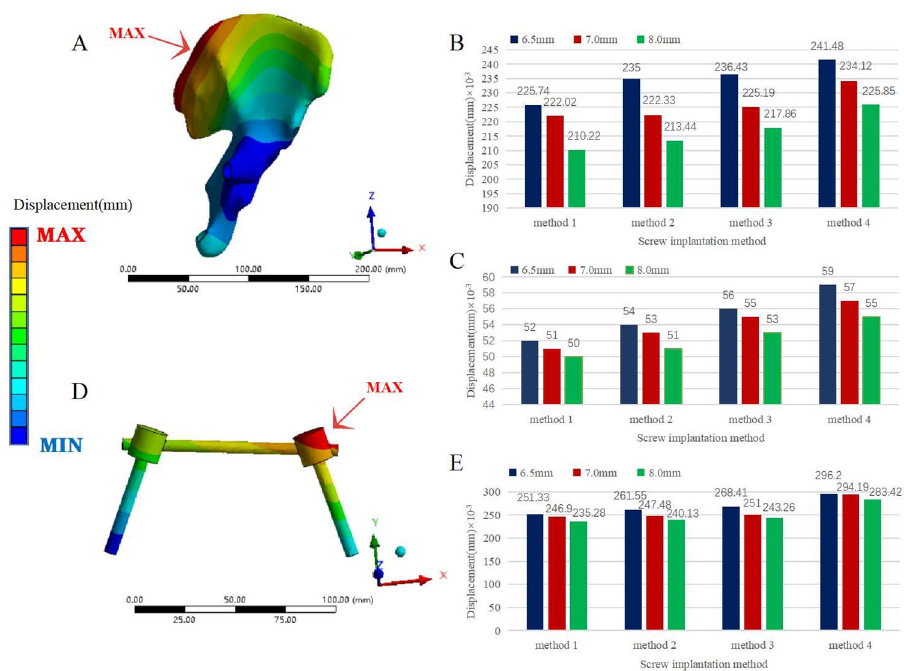
Fig 7. Displacement comparison of pedicle screw fixation models with different diameters and fixation methods. (A) Displacement distribution of the iliac bone of the pelvis model fixed with pedicle screws under a vertical load. (B) Comparison of the maximum displacement of the iliac bone of the pelvic model with pedicle screws of three diameters and four fixation methods under a vertical load. (C) Comparison of the maximum displacement of the pubic ramus fracture of the pelvic model with pedicle screws of three diameters and four fixation methods under a vertical load. (D) Displacement distribution of the pedicle screw rod in the posterior ring of the pelvic model fixed with pedicle screws under a vertical load. (E) Comparison of the maximum displacement of the pedicle screw rod in the posterior ring of the pelvic model with pedicle screws of three diameters and four fixation methods under a vertical load.